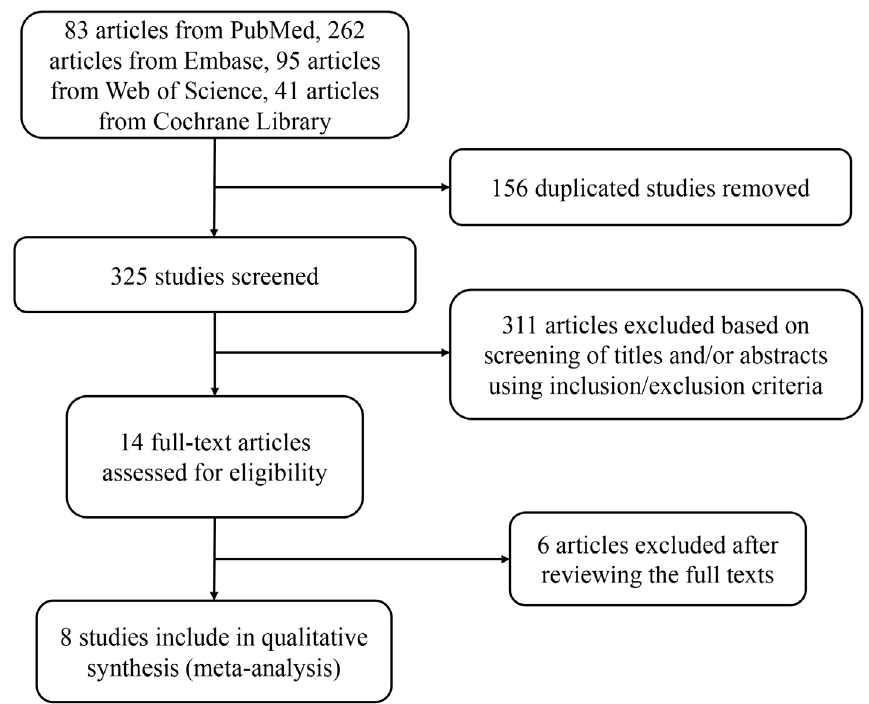
Figure 1. Flow chart of literature selection.